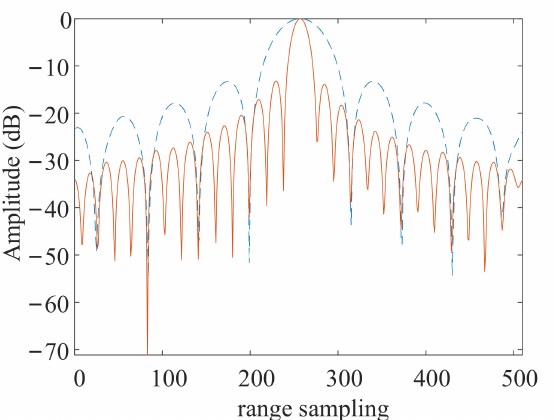
Figure 8. Range profile before and after frequency band synthesis of point target P 1